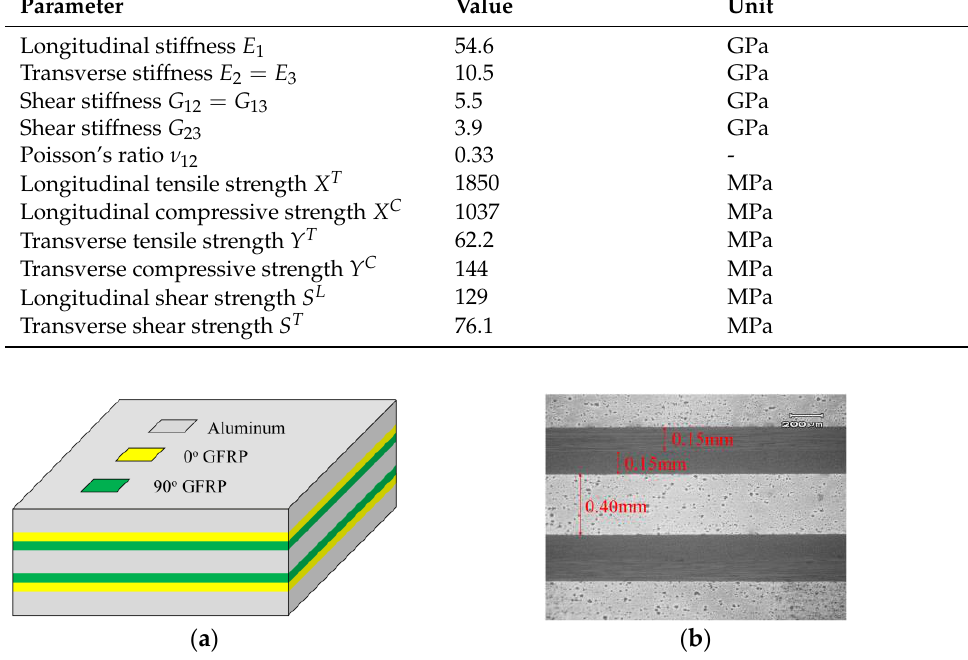
Figure 2. Configuration of the Glare: ( a ) Schematic view; ( b ) Cross-section view by SEM. Table 2. Mechanical properties of 2024-T3 aluminum sheet [21].